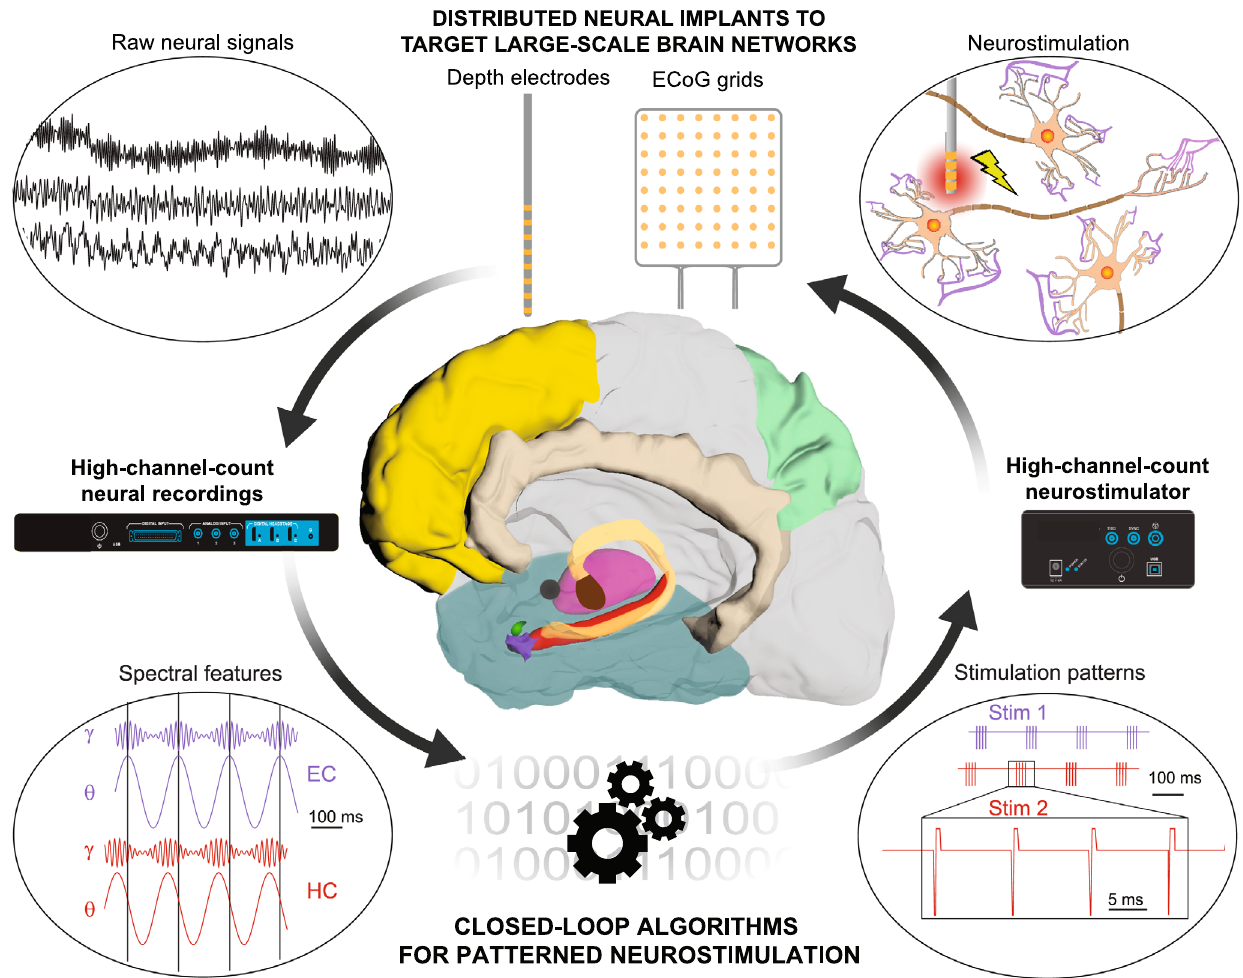
Fig. 4 Towards large-scale bidirectional neuroprostheses for memory disorders. Future neuroprosthetic systems for memory restoration may bene fi t from distributed multi-electrode implants targeting large-scale brain networks, combining depth electrodes, ECoG grids and potentially novel electrode technologies for combined recordings and stimulation. Field potentials measured by these implants would then be sent to computing devices via high- channel-count recording systems. These computing devices would extract in real-time speci fi c spectral features of these raw neural signals, such as the instantaneous power, phase and phase-amplitude coupling of theta and gamma oscillations in hippocampal structures. These features would then be used as control signals in closed-loop algorithms that deliver spatially, temporally and spectrally patterned neurostimulation protocols to enhance the neural features of successful memory processes (encoding or retrieval). These complex stimulation patterns would next be applied to the distributed neural implants via high-channel-count neurostimulators. Neurostimulation would fi nally affect neuronal activity through mechanisms that depend on the geometry of local fi bers, which can be explained or theoretically predicted by computational models of neurostimulation. Schematics of high-channel-count recording and stimulation systems were adapted with permission from Blackrock